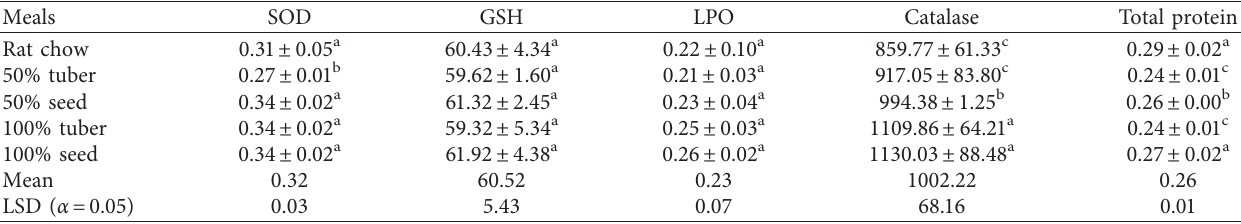
Table 2: Effect of African yam bean seed and tuber meal on superoxide dismutase (SOD), lipid peroxidation (LPO), reduced glutathione (GSH), catalase, and total protein on the testis of healthy Wistar albino rats 72h after administration. Meals SOD